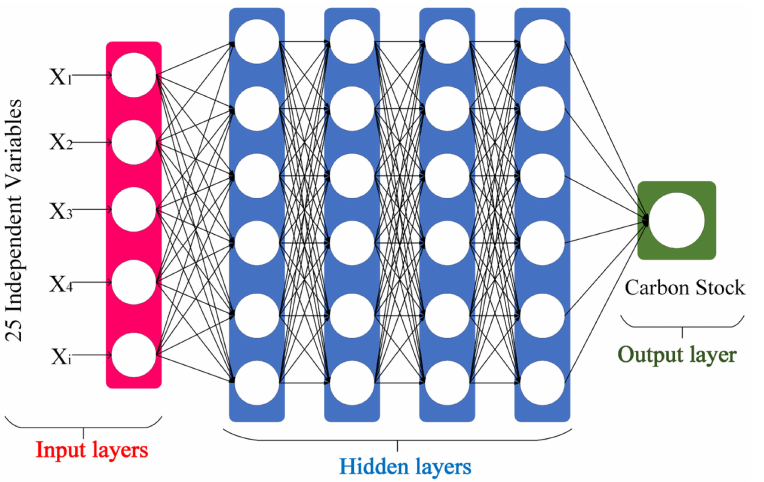
Figure 3. Scheme of a deep neural network framework, including input layers, multiple hidden layers and output